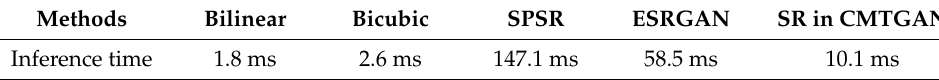
Table 5. Inference time of